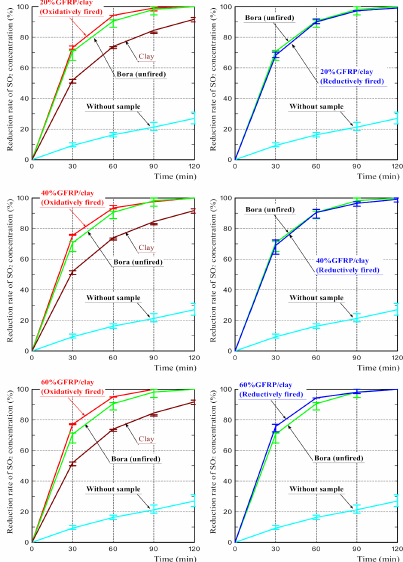
Figure 7. SO 2 concentration reduction rates for the